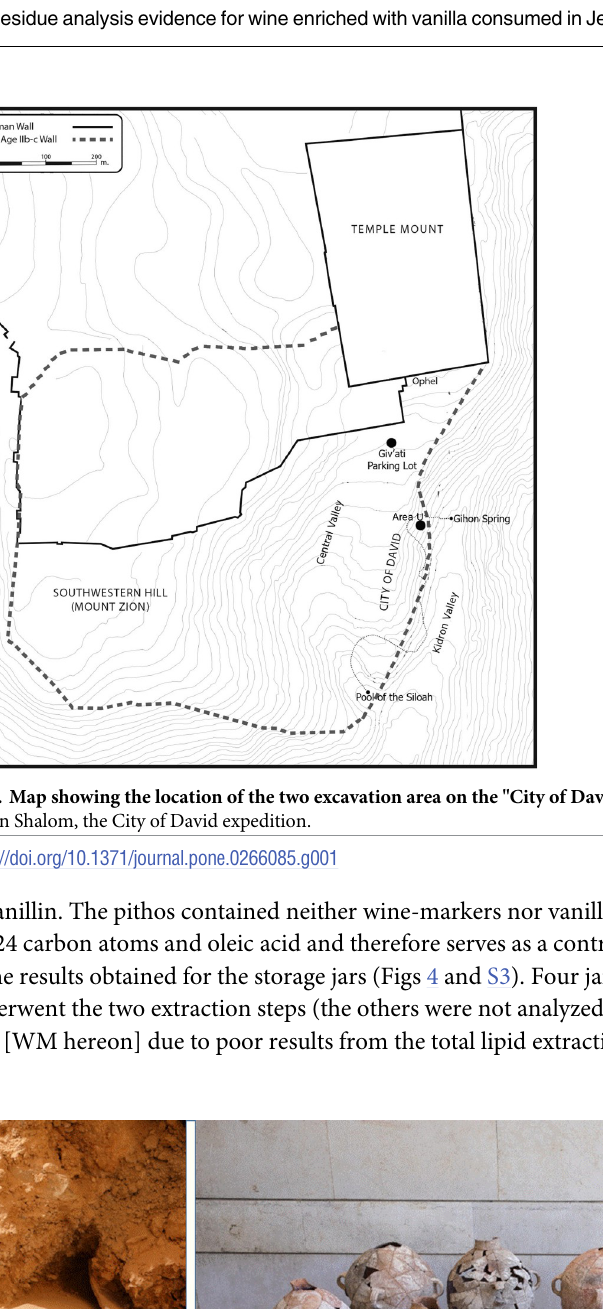
Fig 2. Vessels found in Room C, Building 100. a. The smashed jars while being excavated inside Room C. b. The assemblage of storage jars found inside Room C following restoration. Photographed by Sasha Flit, Tel-Aviv